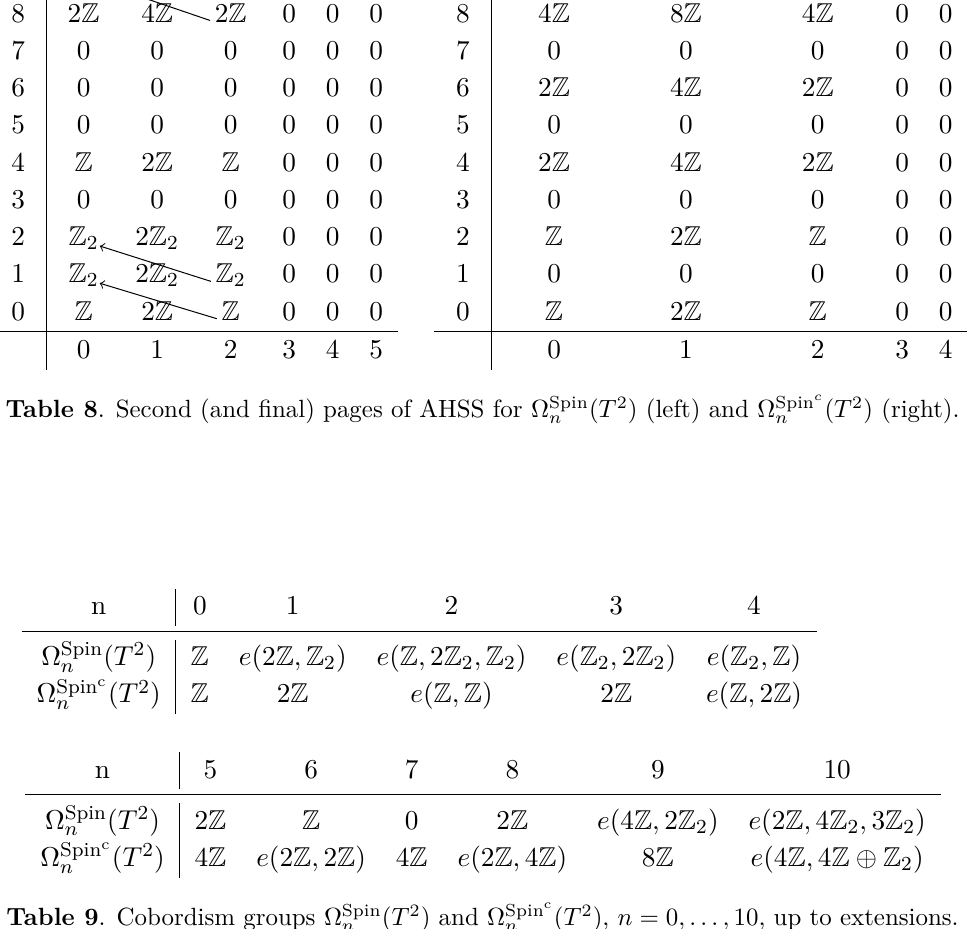
Table 9 . Cobordism groups Ω Spin